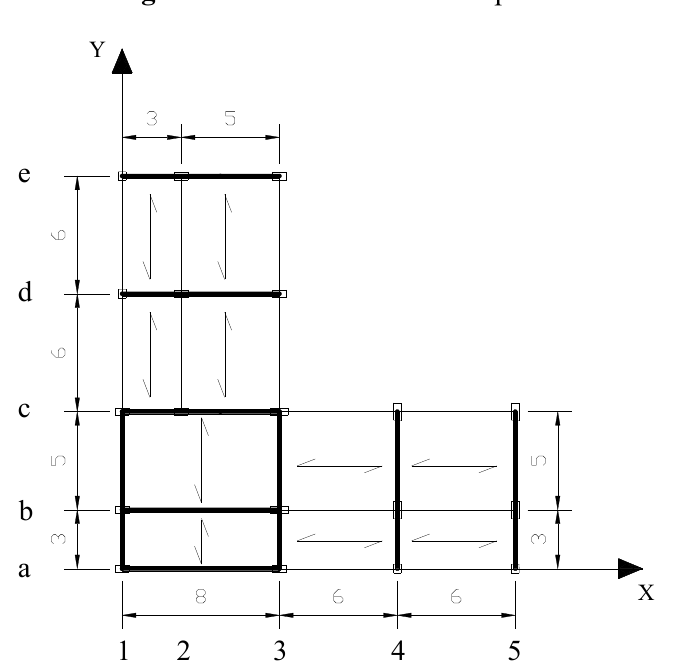
Figure 1. Benchmark structure plan.